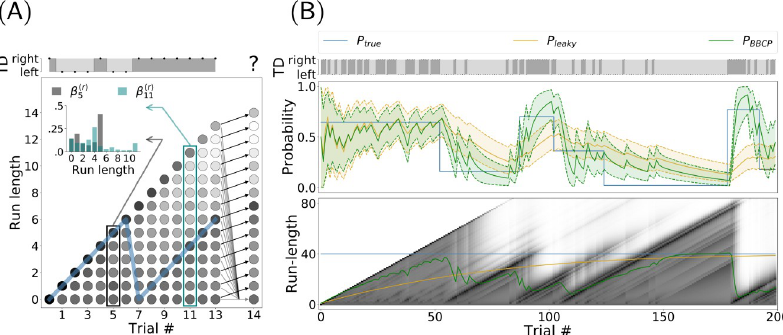
Fig 2. Binary Bayesian Change-Point (BBCP) detection model. ( A ) This plot shows a synthesized sequence of 13 events, either a leftward or rightward movement of the target (TD). Run-length estimates are expressed as hypotheses about the length of an epoch over which the probability bias was constant, that is, the number of trials since the last switch. Here, the true probability bias switched from a value of .5 to .9 at trial 7, as can be seen by the trajectory of the true run-length (blue line). The BBCP model tries to capture the occurrences of a switch by inferring the probability of different possible run-lengths. At any new datum (trial), this defines a Hidden Markov Model as a graph (trellis), where edges indicate that a message is being passed to update each node’s probability (as represented by arrows from trial 13 to 14). Black arrows denote a progression of the run-length at the next step (no switch), while gray lines stand for the possibility that a switch happened: In this case the run-length would fall back to zero. The probability for each node is represented by the grey scale (darker grey colors denote higher probability) and the distribution is shown in the inset for two representative trials: 5 and 11. Overall, this graph shows how the model integrates information to accurately identify a switch and produce a prediction for the next trial (e.g. for t = 14). ( B ) On a longer sequence of 200 trials, representative of a trial block of our experimental sequence (see Fig 1A), we show the actual events which are observed by the agent (TD), along with the (hidden) dynamics of the true probability bias P true (blue line), the value inferred by a leaky integrator ( P leaky , orange line) and the results of the BBCP model in estimating the probability bias P BBCP (green line), along with .05 and .95 quantiles (shaded area). This shows that for the BBCP model, the accuracy of the predicted value of the probability bias is higher than for the leaky integrator. Below, we show the belief (as grayscales) for the different possible run-lengths. The green and orange line correspond to the mean run-length which is inferred, respectively, by the BBCP and leaky models: Note that in the BBCP, while it takes some trials to detect switches, they are in general correctly identified (transitions between diagonal lines) and that integration is thus faster than for the leaky integrator, as illustrated by the inferred value of the probability